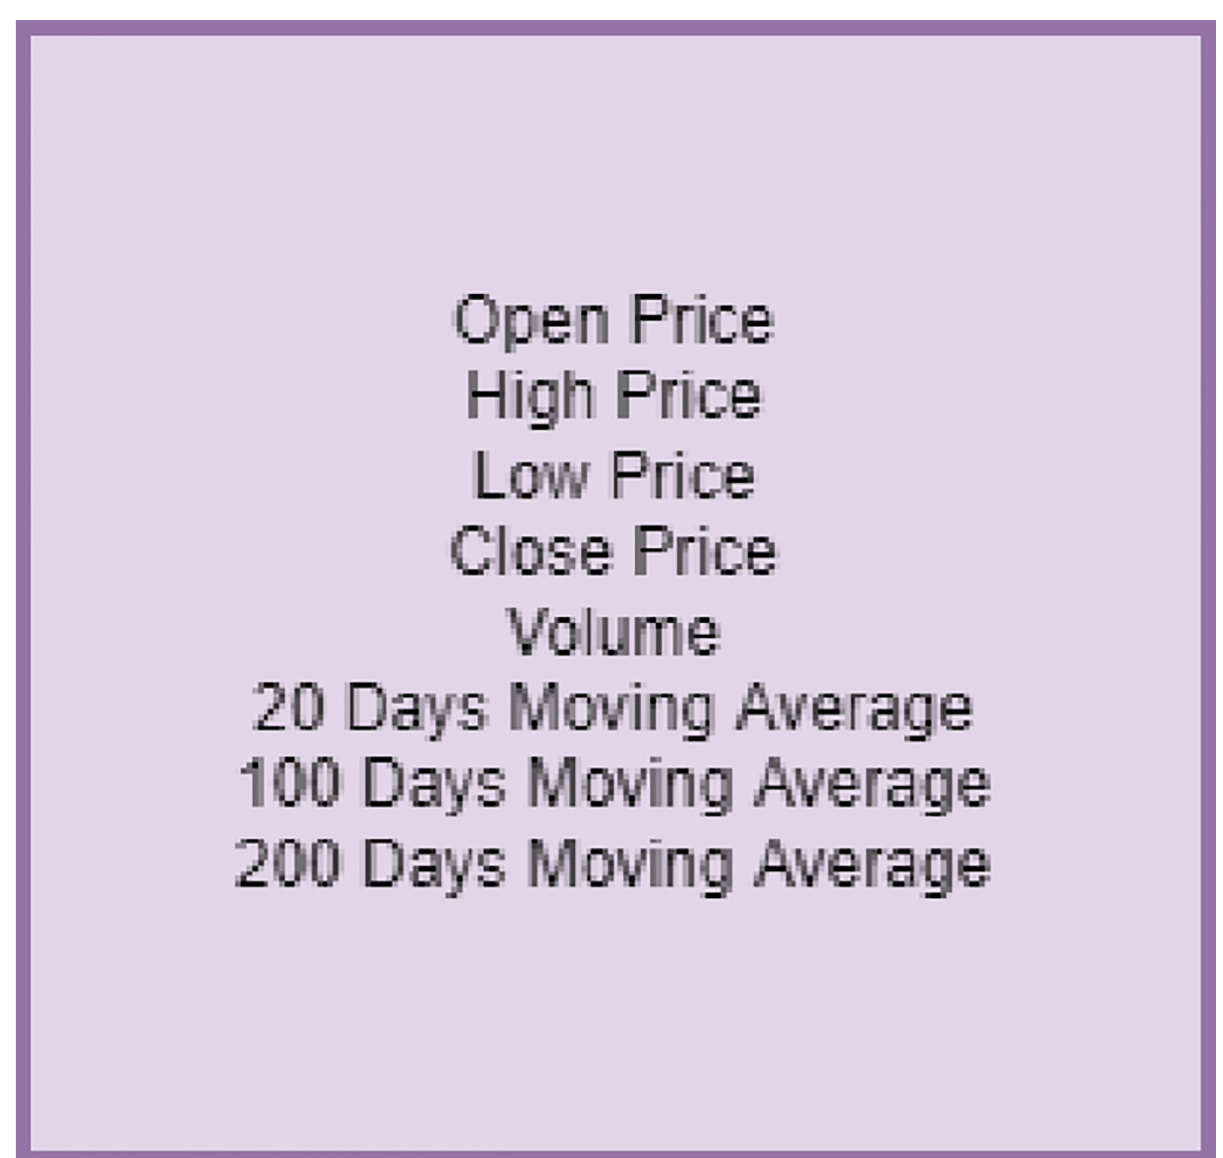
Fig 9. Stock crisis input